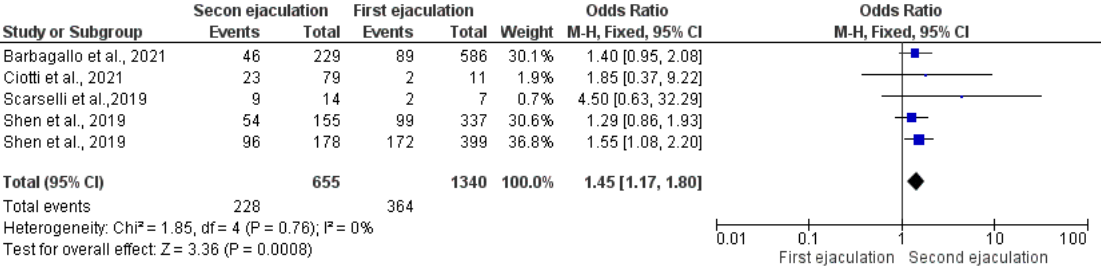
Figure 3. Forest plot of studies showing the effects of a very short abstinence period on implantation